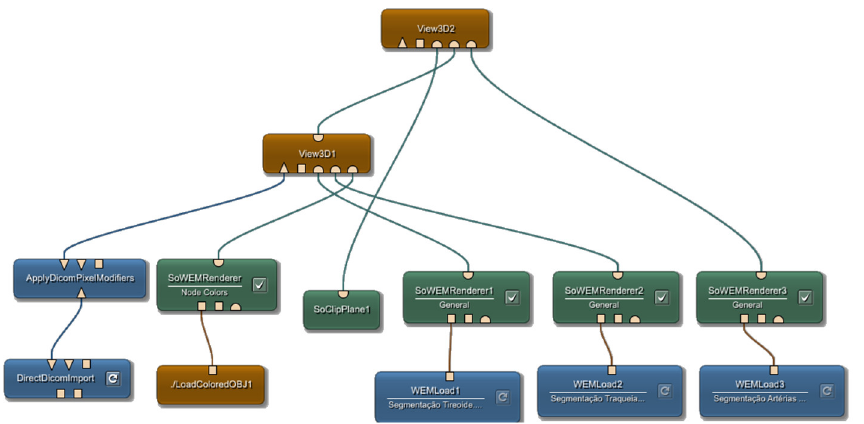
Figure 13. Representation of the network of modules used in MeVisLab ® to generate the complete 3D visualization. 3D